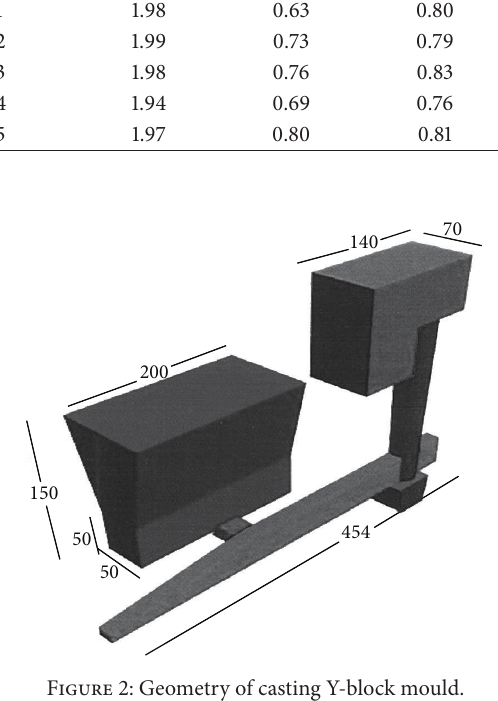
Figure 2: Geometry of casting Y-block